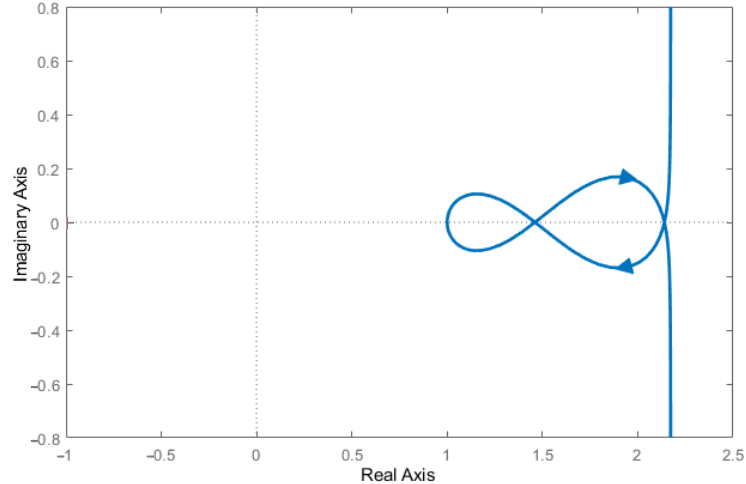
Figure 14. Nyquist diagram of the linear system G ∗ ( s ) .